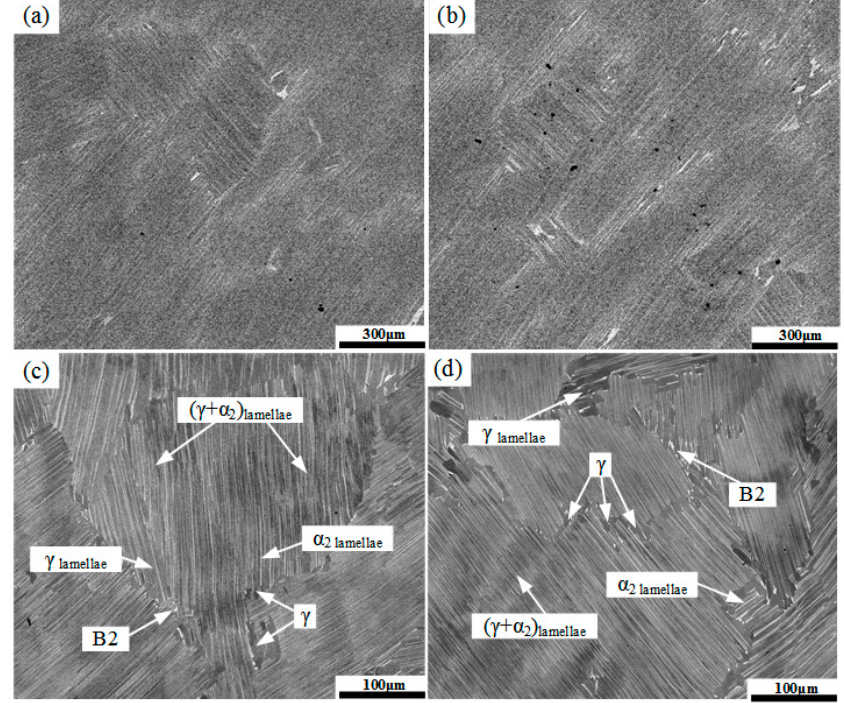
Figure 2. SEM microstructures of the unhydrogenated ( a , c ) and hydrogenated ( b , d ) Ti–45Al–9Nb alloys. ( c , d ) are the magnified images of ( a , b ), respectively.